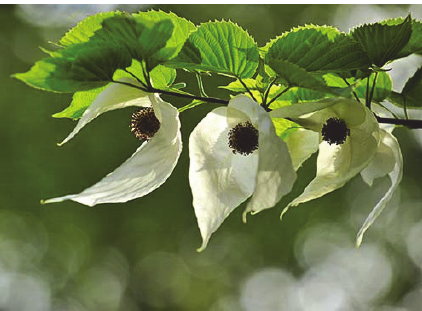
Figure 1: The flowers of Davidia involucrata that tremble in a slight breeze.